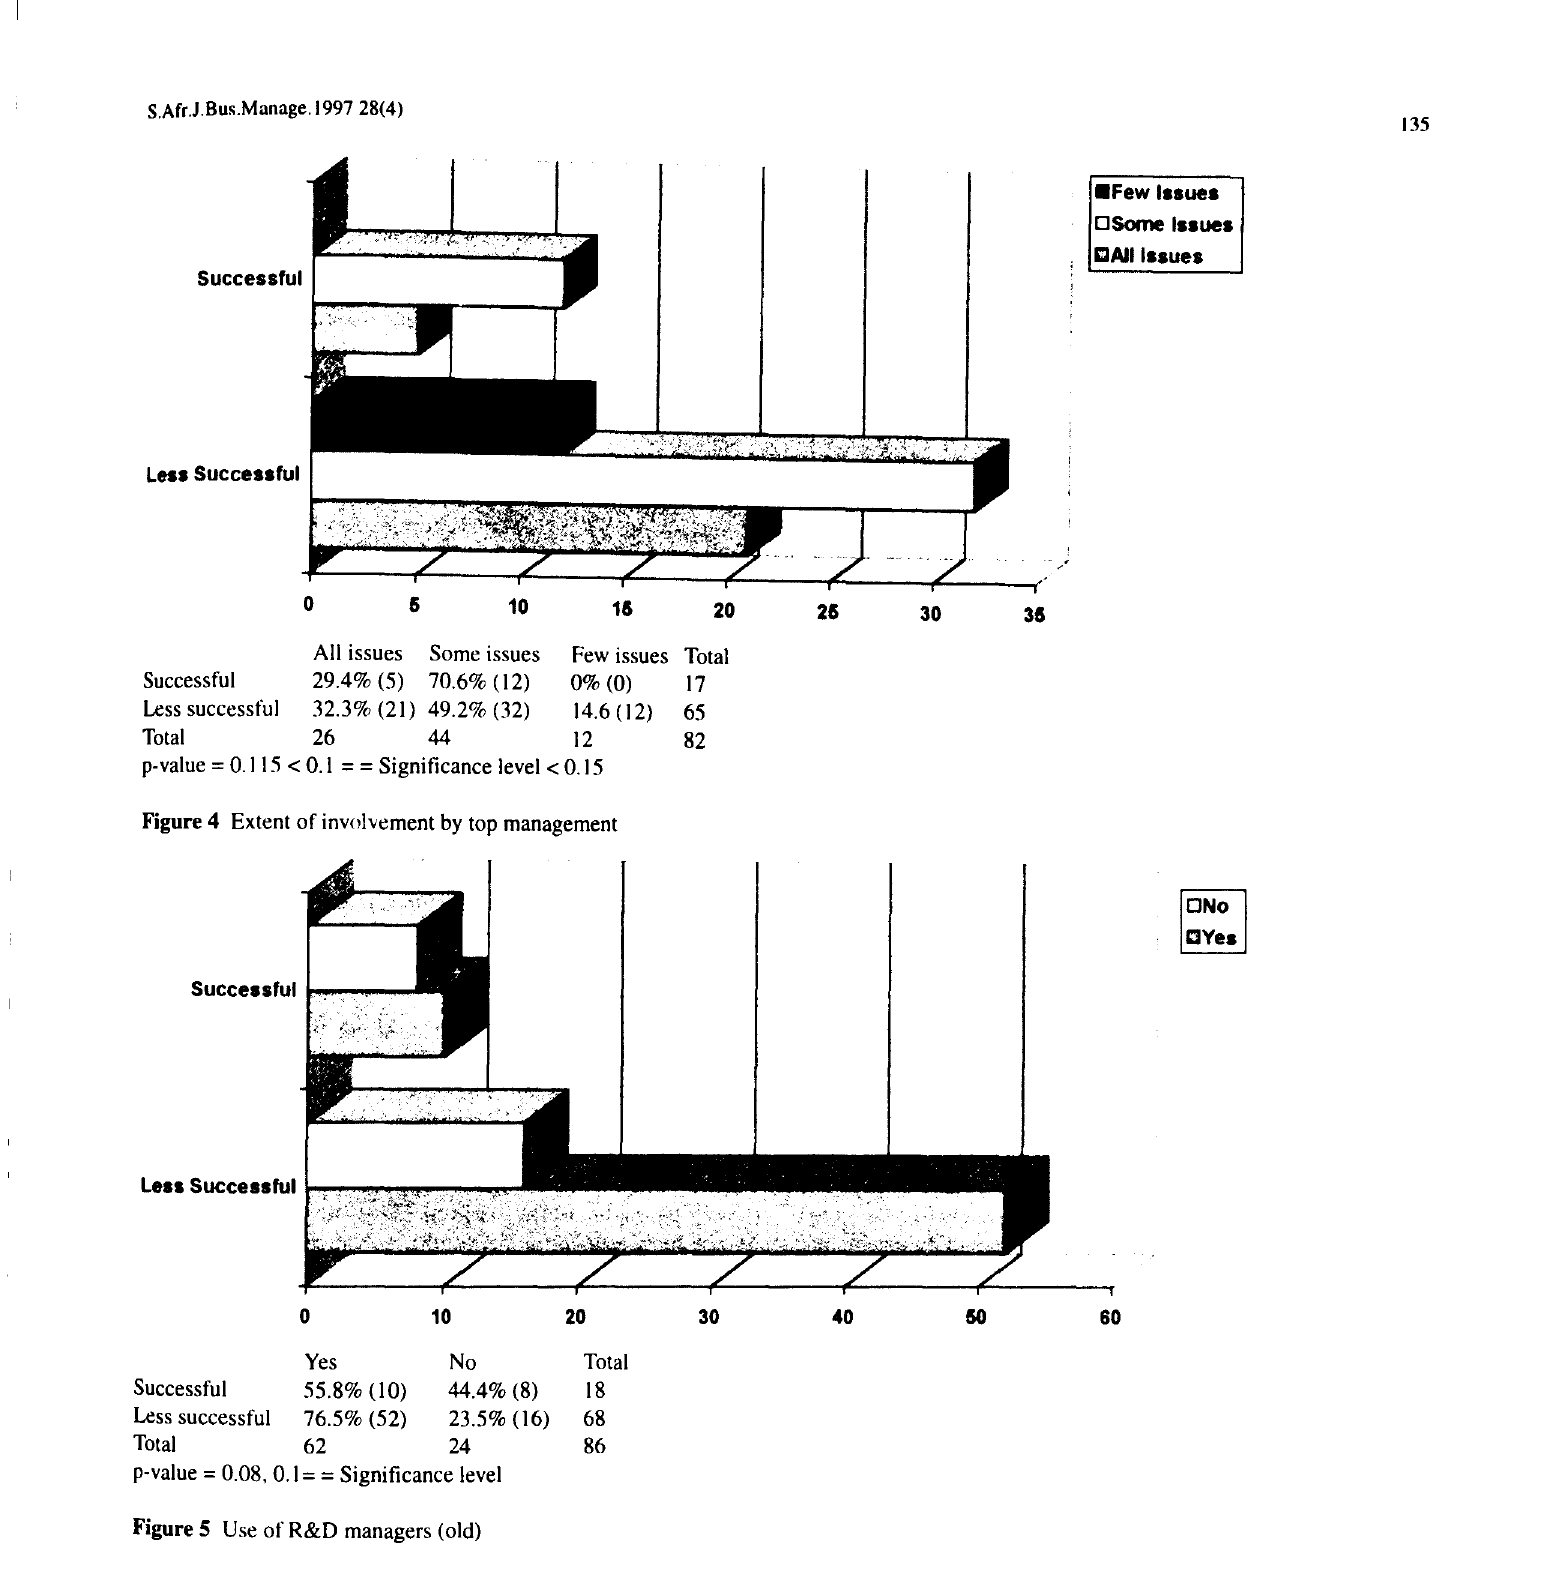
Figure 4 Extent of involvement by top management